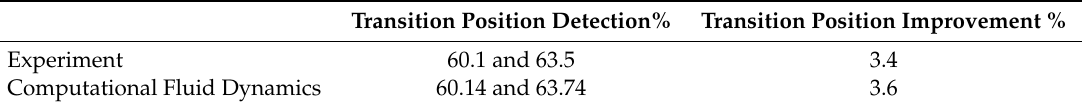
Figure 3. Comparison of laminar transition position and pressure distribution between CFD (Computational Fluid Dynamics) simulation and EXP (experiment) result. Table 2. Comparison of laminar length: wind-tunnel experiment vs. CFD